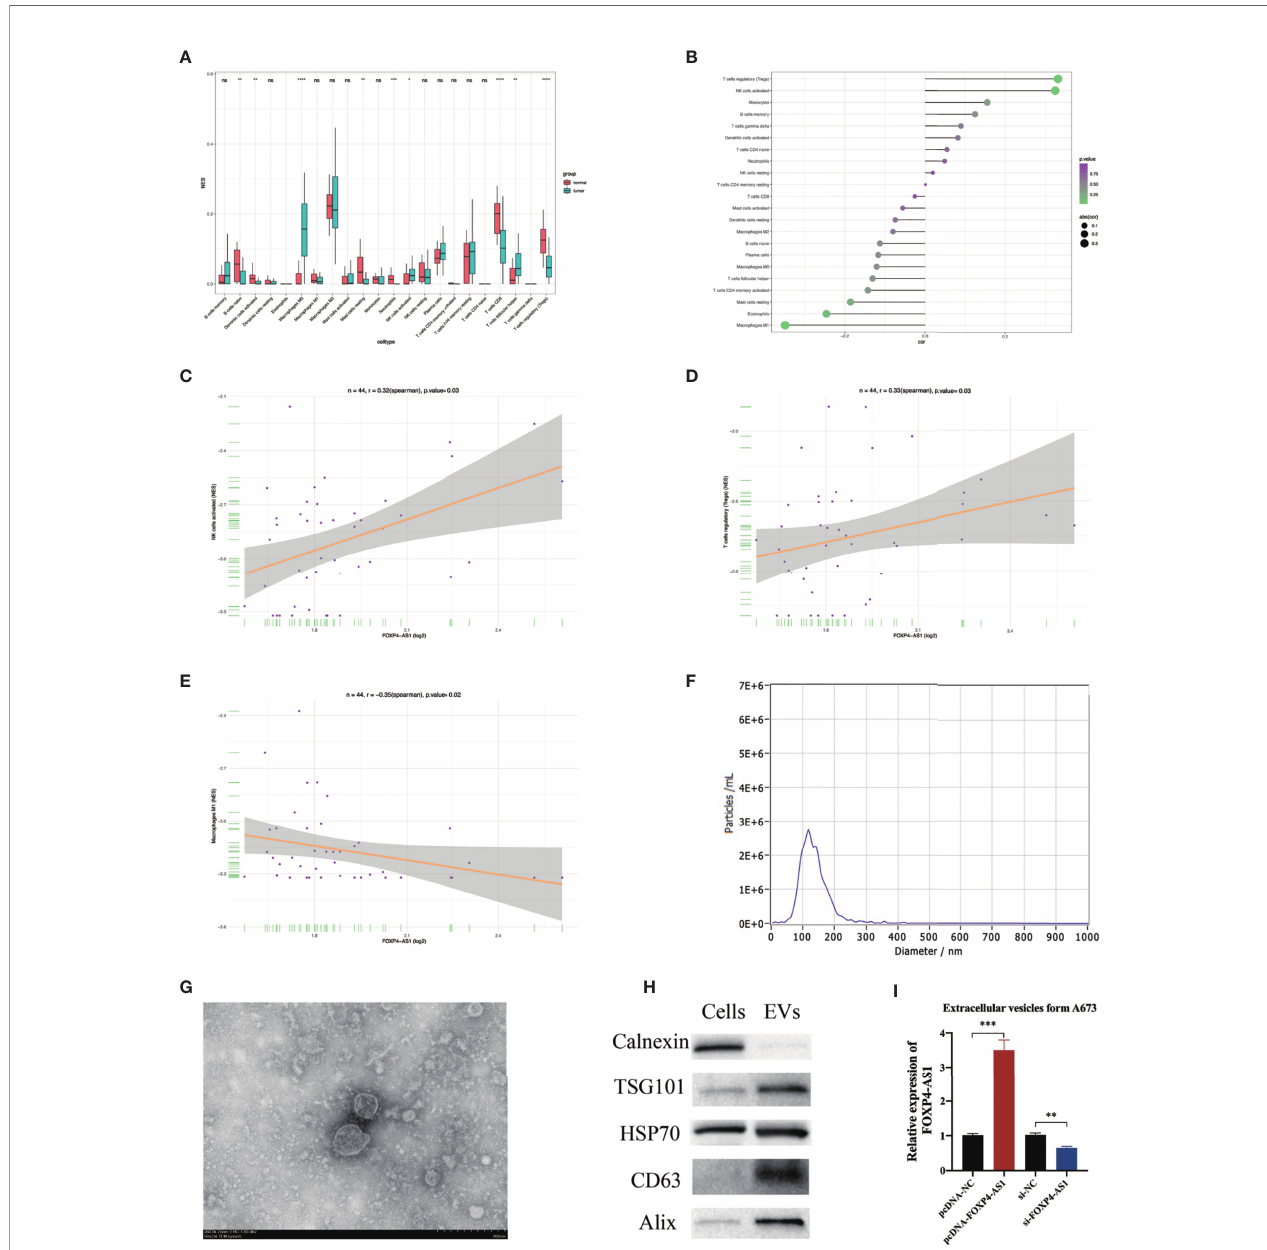
FIGURE 8 | The correlation between FOXP4-AS1 expression and immune in fi ltration. (A) In fi ltration level of 22 immune cells in skeletal muscle and ES patient samples was estimated by CIBERSORT. (B) The correlation between FOXP4-AS1 expression and immune cell enrichment level was analyzed by Spearman correlation analysis. (C, D) FOXP4-AS1 expression was remarkably positively correlated with T cells regulatory (Tregs), NK cells activated. (E) FOXP4-AS1 expression was remarkably negatively correlated with Macrophages M1. (F) The particle size of the extracellular vesicles was analyzed with Nanoparticle Tracking Analysis (NTA). (G) The morphology of extracellular vesicles was determined by Transmission electron microscopy (TEM). (H) Western blot was used to quantify the protein levels of markers of extracellular vesicles. (I) FOXP4-AS1 expression in A673-derived extracellular vesicles following overexpression or knockdown of FOXP4-AS1 in A673 cells. *p < 0.05, **p < 0.01, ***p < 0.001, ****p < 0.0001, ns, non-signi fi